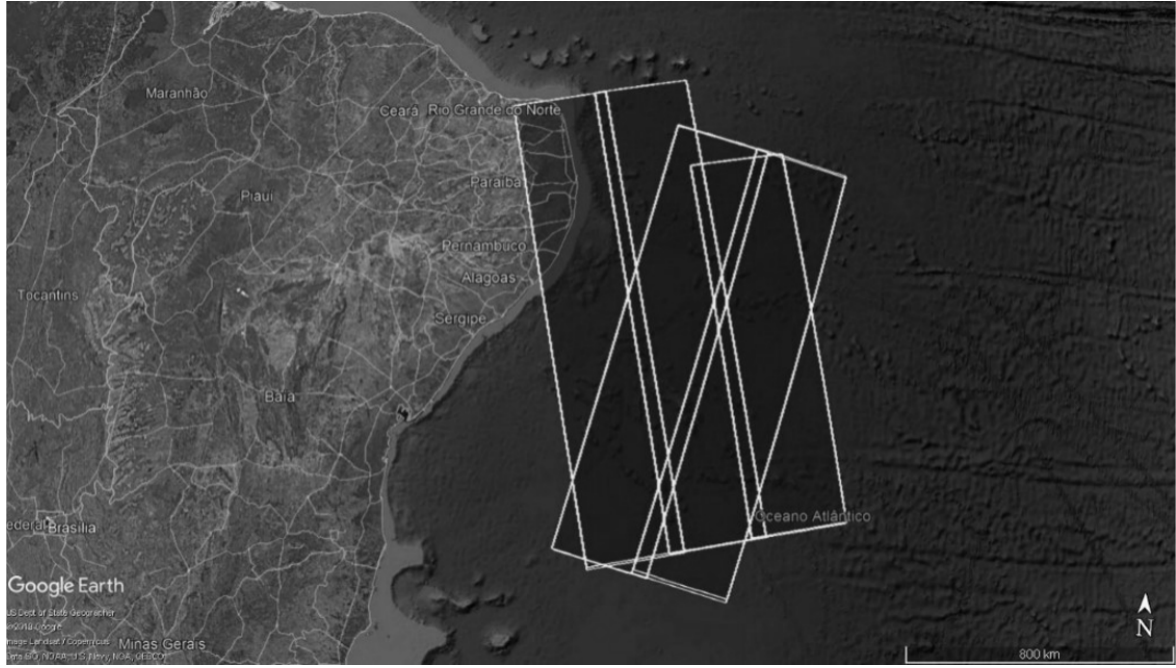
Figure 3. Sentinel 1 expanded covered area (Ibama 2020, Source: